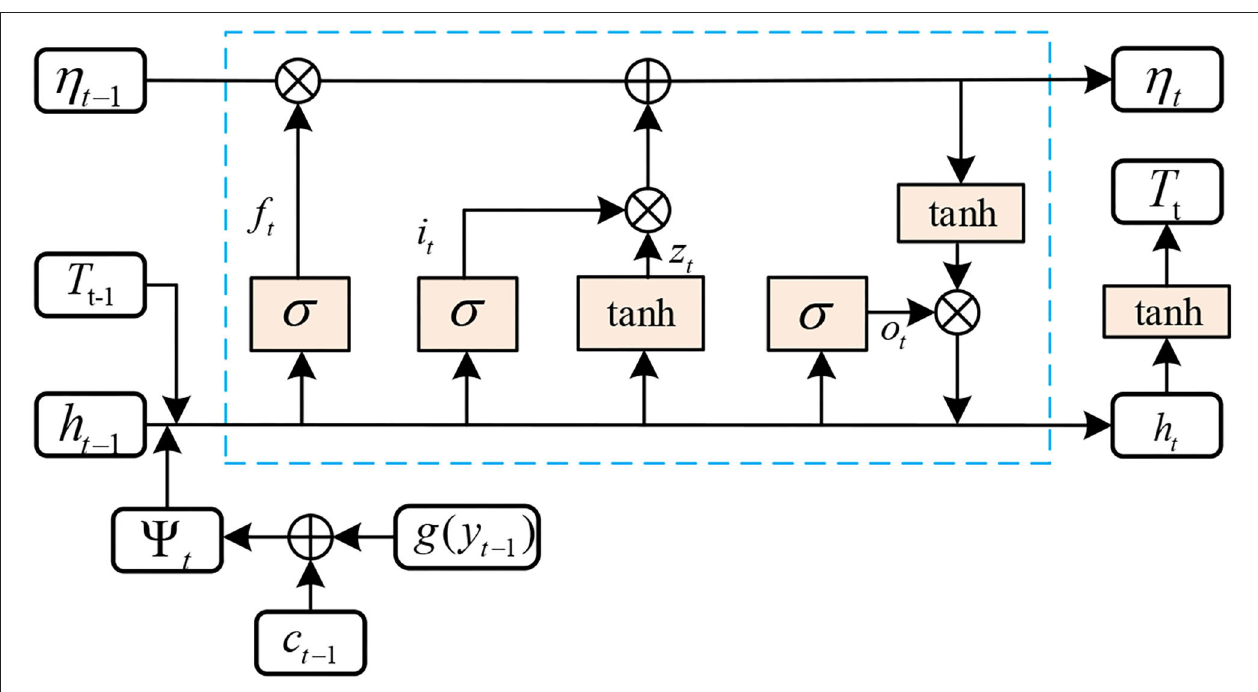
FIGURE 4 | The structure of MGLSTM.